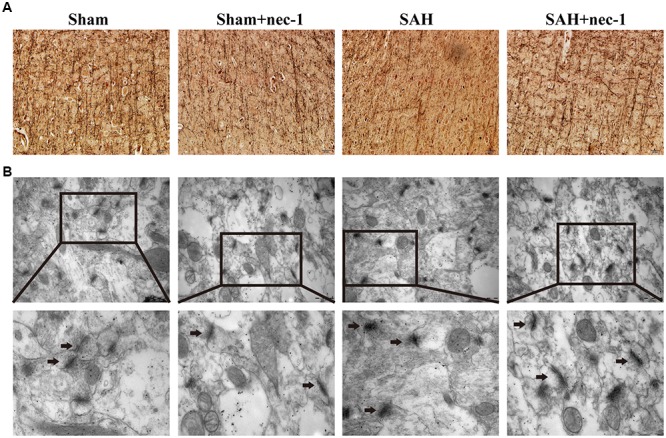
Nec-1 rescues synaptic impairments after SAH. (A) In silver staining, the impairments after SAH were clearly observed, and the number of nerve fibers in the SAH group decreased significantly. Nec-1 could increase the number of nerve fibers. Scale bar = 50 μm. (B) Morphology of the synapse was observed by electron microscope. In the Sham and Sham+nec-1 groups, presynaptic structures were clearly seen. However, in the SAH group, the structure of the synapse was damaged. The injection of nec-1 could effectively attenuate the damage. The arrows showed the structure of the presynaptic and postsynaptic membranes, and the synaptic cleft. Scale bar = 500 nm.